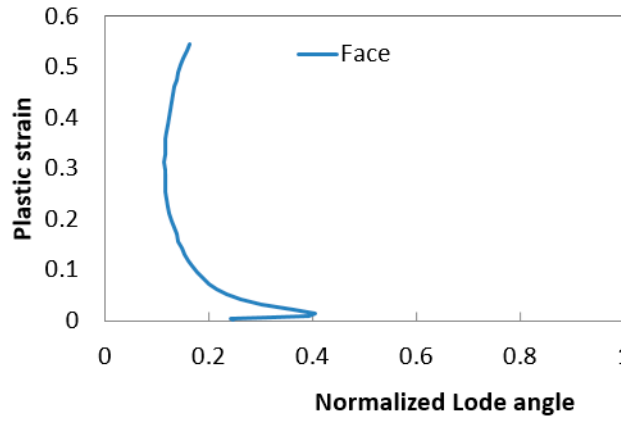
Figure 28. Lode angle for shear test.